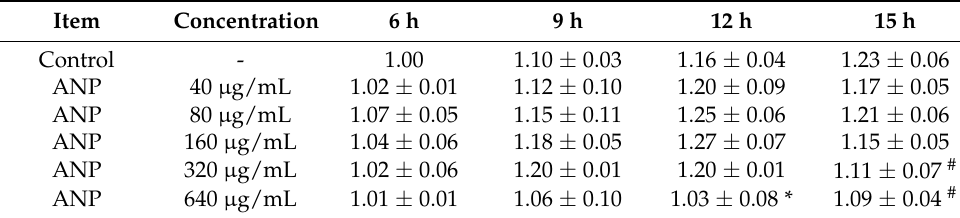
Table 1. The effect of areca nut polyphenol extract on the viability of RAW264.7 cell. Item